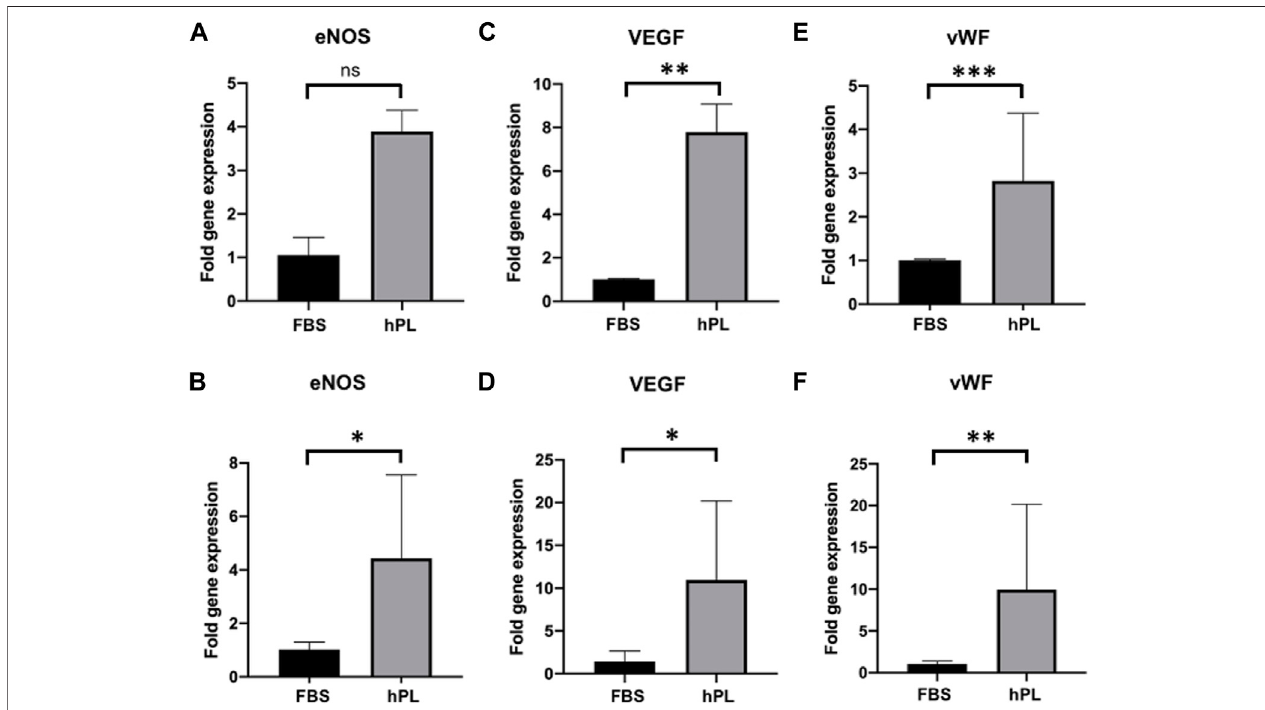
FIGURE 6 | Gene expression pro fi le of hTEMs seeded with ECFCs under static and dynamic orbital conditions using FBS or hPL as medium supplement after 5 days of culture. The gene expression is displayed in dCt and normalized on the average expression level of the housekeeping gene glyceraldehyde-3-phosphate dehydrogenase (GAPDH). (A,B) : eNOS expression under static (A) and dynamic orbital (B) conditions. (C,D) : VEGF expression under static (C) and dynamic orbital (D) conditions. (E,F) :vWFexpressionunderstatic (E) anddynamicorbital (F) conditions.Thecutoffforstatisticalsigni fi cancewasconsideredtobe p < 0.05(* p < 0.05; ** p < 0.01; *** p < 0.001). ns = non-signi fi cant.